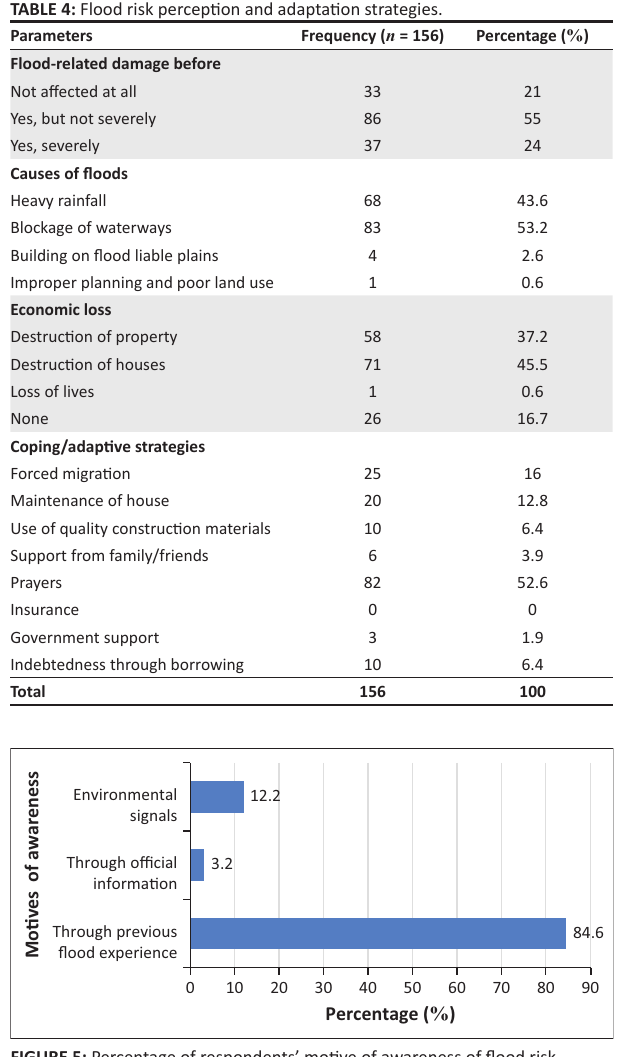
FIGURE 5: Percentage of respondents’ motive of awareness of flood risk.